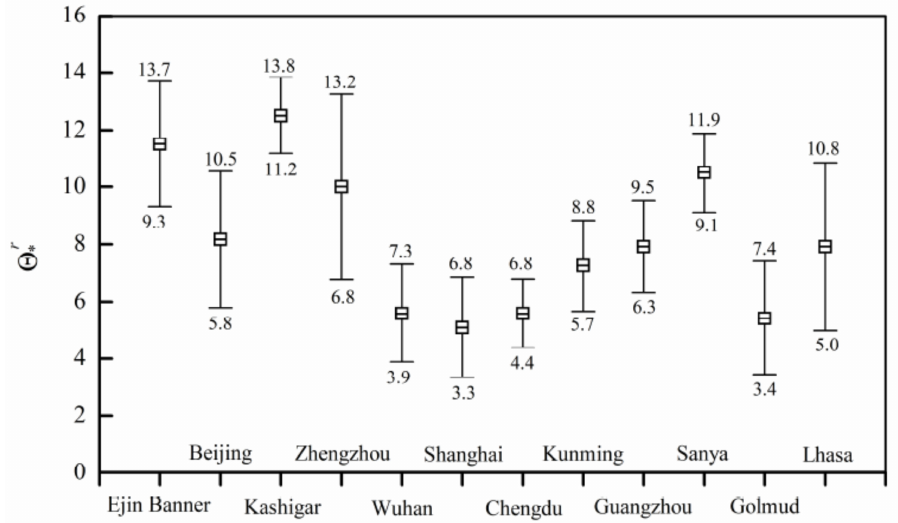
Figure 10. Mean and standard deviation of Θ r ∗ for collecting temporally stable time series at 12 selected